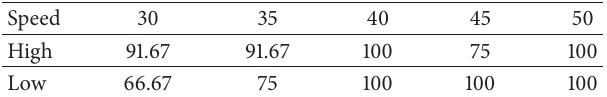
Table 2: The performance of SVM in FSFL model when the 1D LBP scheme is used for feature extraction.